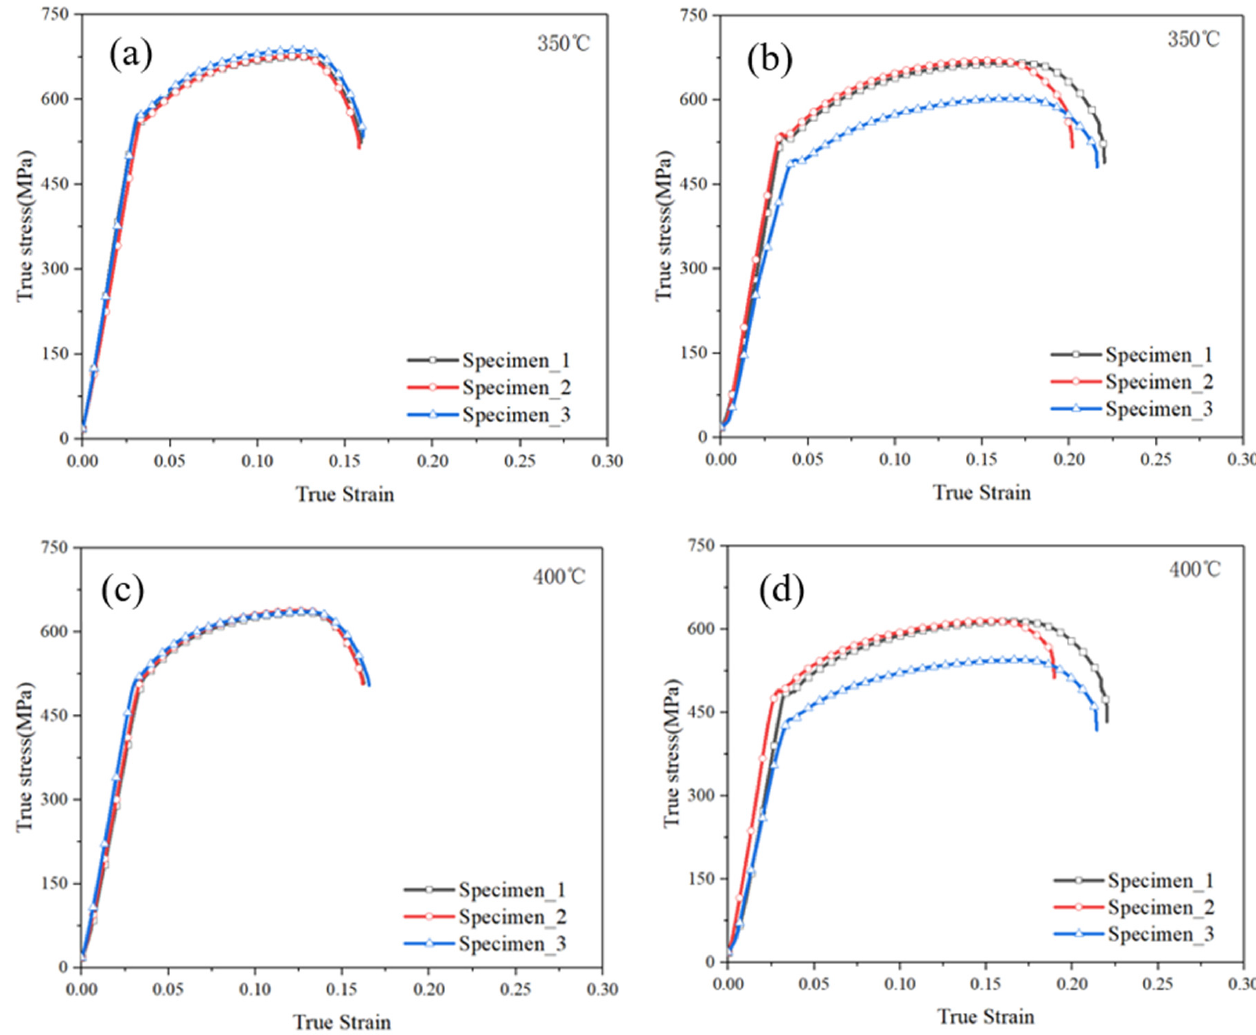
Figure 4. The stress–strain curve of the heat-treated SP700 alloy at ( a ) 350 °C and ( c ) 400 °C when the diffusion bonding process is done. The engineering stress–strain curves of the initial alloy at ( b ) 350 °C and ( d ) 400 °C after diffusion bonding.